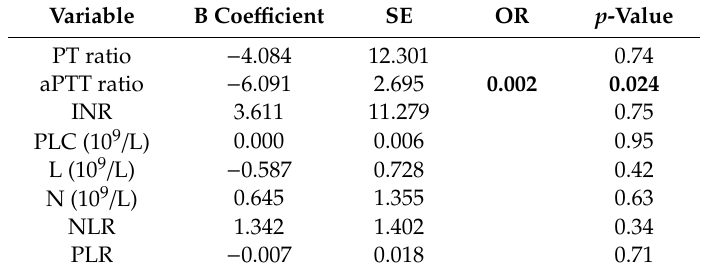
Figure 1. Boxplots of levels of coagulation parameters and systemic inflammatory response